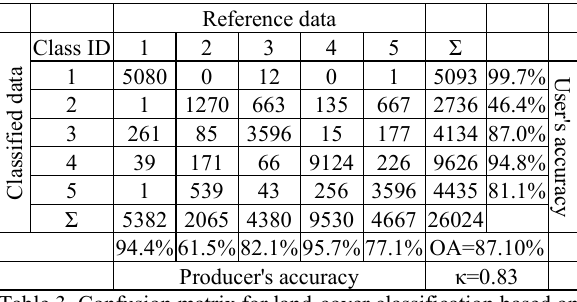
Table 3. Confusion matrix for land-cover classification based on the PS imagery